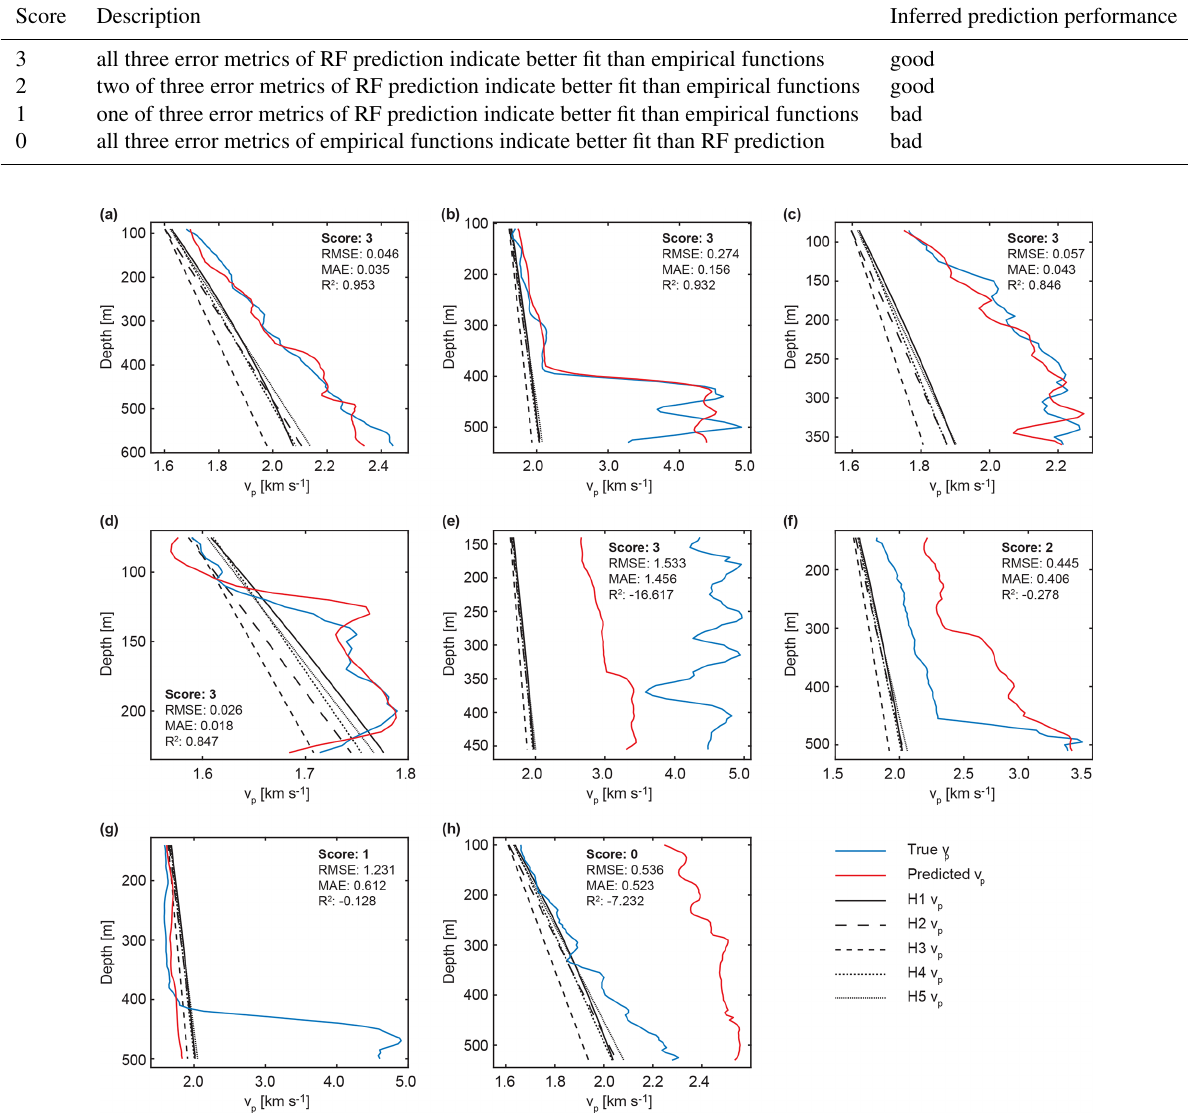
Table 2. Scores for performance comparison between RF prediction and v p calculated from the empirical functions of Hamilton (1985). Score